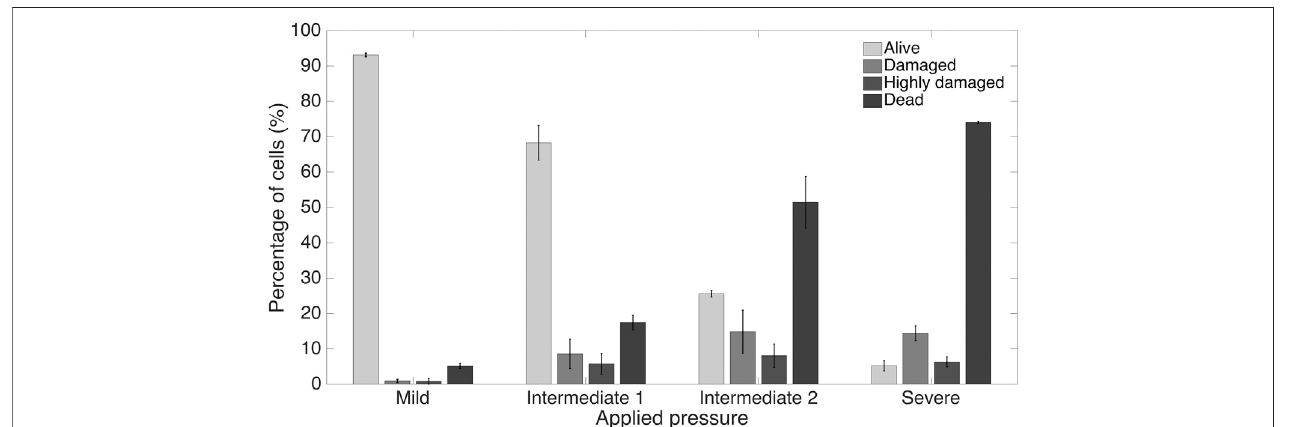
FIGURE 7 | Summary of cancer cell response under the micro-piston to varying applied pressures in ascending order from Mild (15.6 – 15.9 kPa) to Intermediate 1 (23.8 – 26.8 kPa)toIntermediate2(37.8 – 51 kPa)toSevere(127.8 – 140 kPa)outofatleast3independentexperimentsofcycliccompressionusingmicro-pistondevices which were operated at a continuous manner of the applied pressure